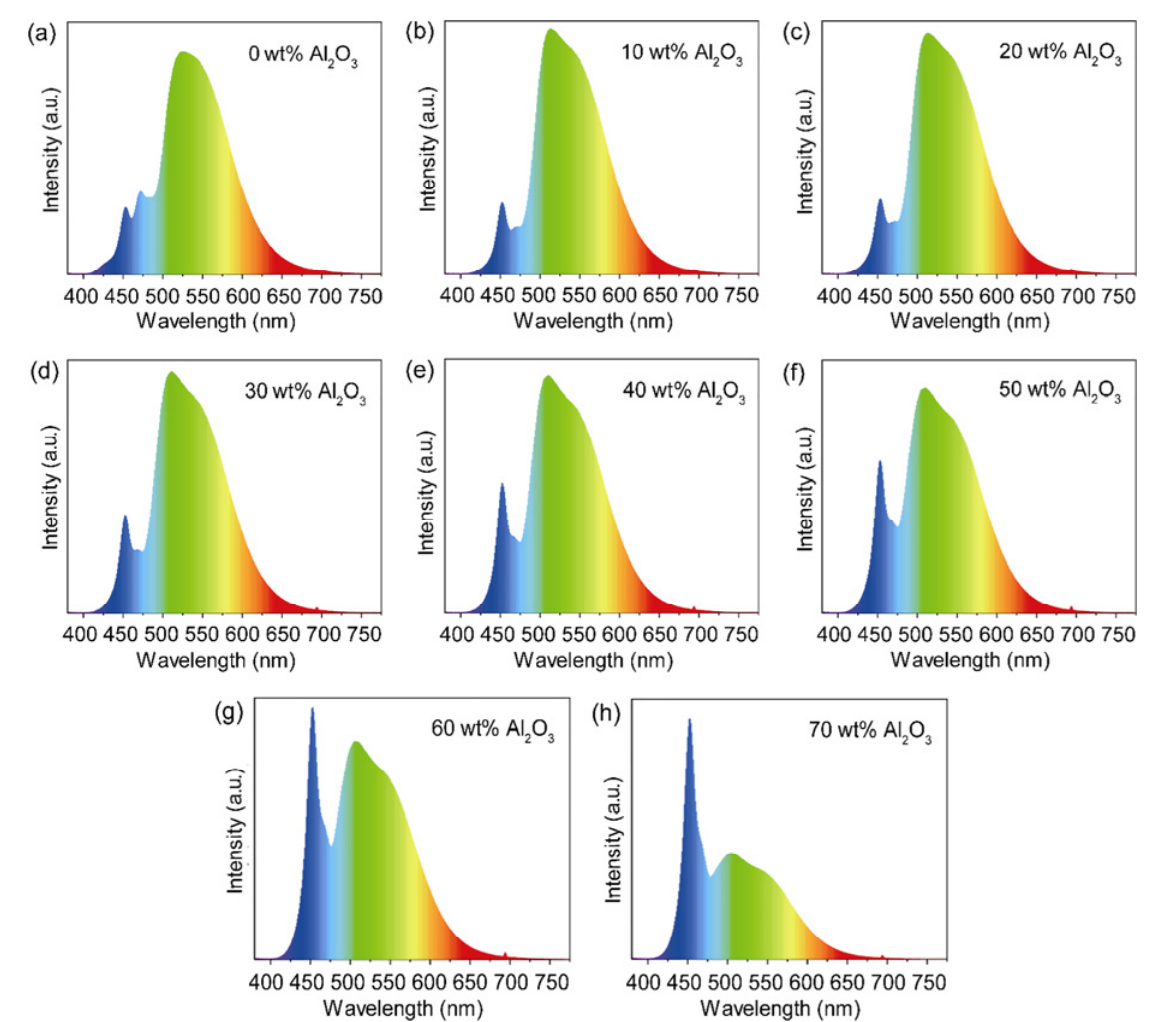
Fig. 5 EL spectra of LACCs with different Al 2 O 3 contents under the excitation of blue COB LEDs. Luminescence properties of LACCs